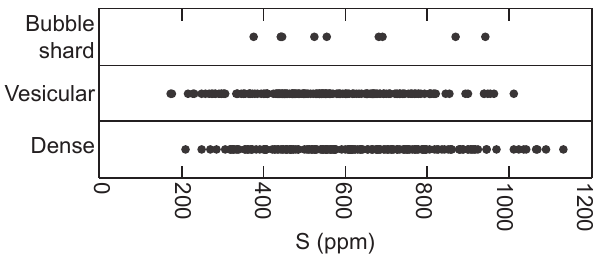
Figure 11: Sulfur concentration as a function of vol- canic glass morphology. Diagram contains analyses of 10 Bubble shards, 192 Vesicular glass grains, and 189 Dense glass